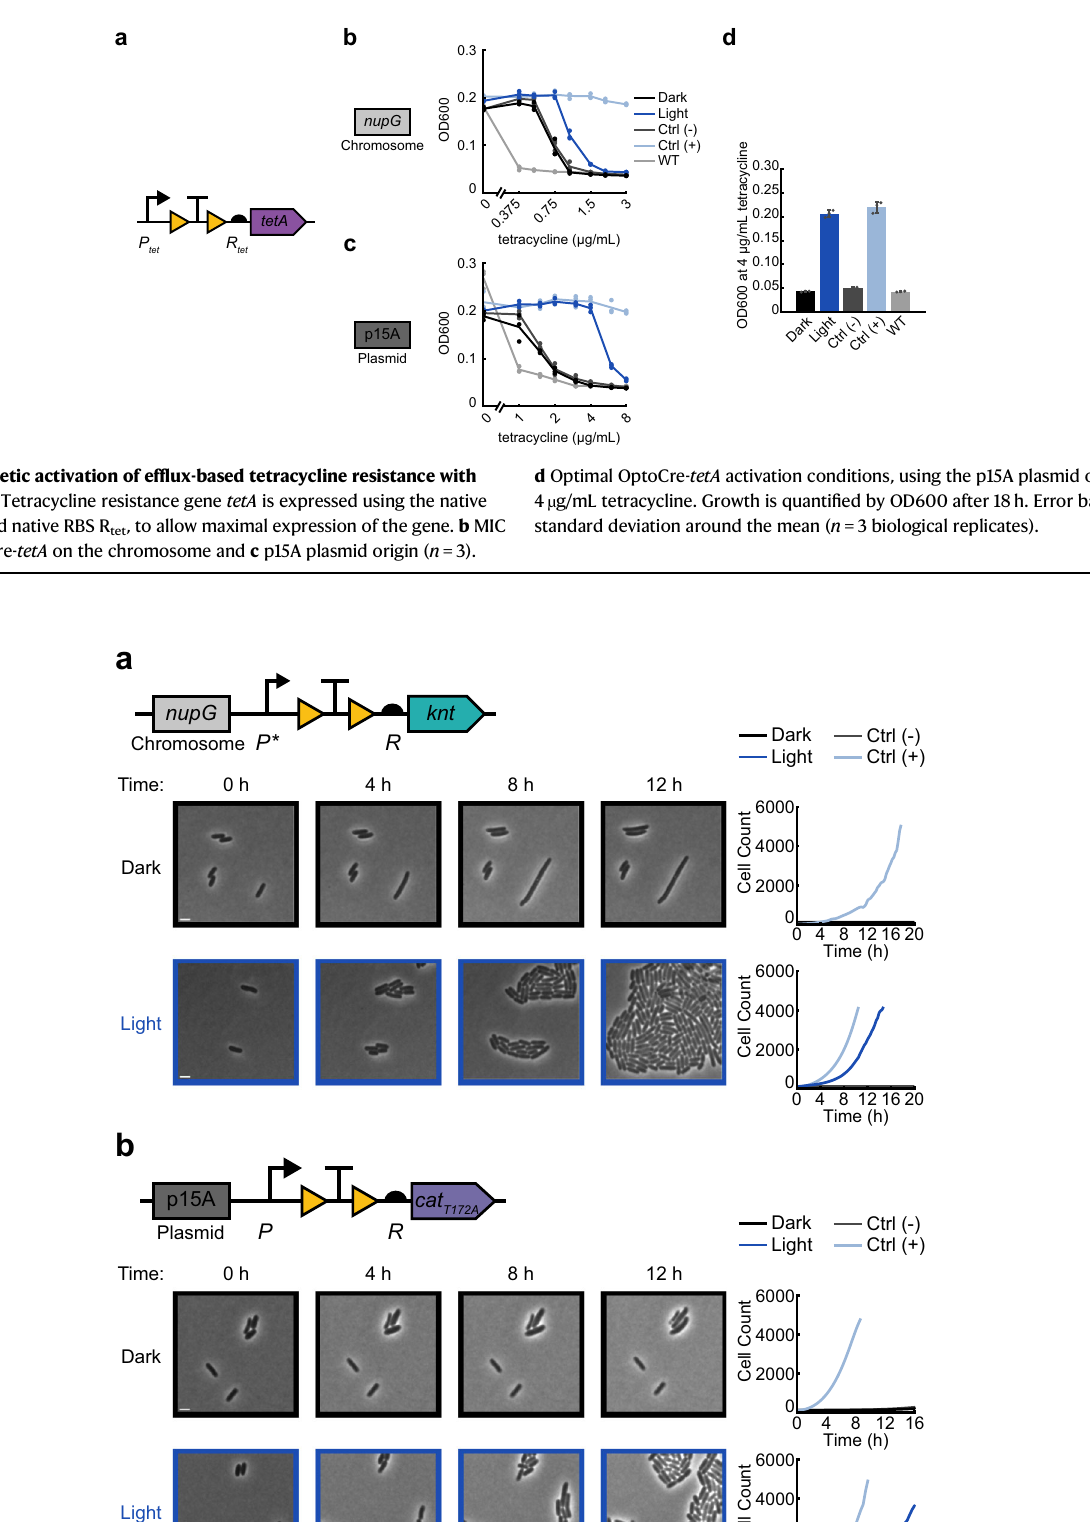
Fig.5|Single-celltime-lapsemicroscopyoflight-inducedantibioticresistance. Activation of a the chromosomal OptoCre- knt resistance construct with promoter P* and RBS R on agarose pads containing 400 µ g/mL kanamycin, and b the p15A plasmid-basedOptoCre- cat resistanceconstructusing cat T172A withpromoterPand RBS R on agarose pads containing 60 µ g/mL chloramphenicol. Microscopy images